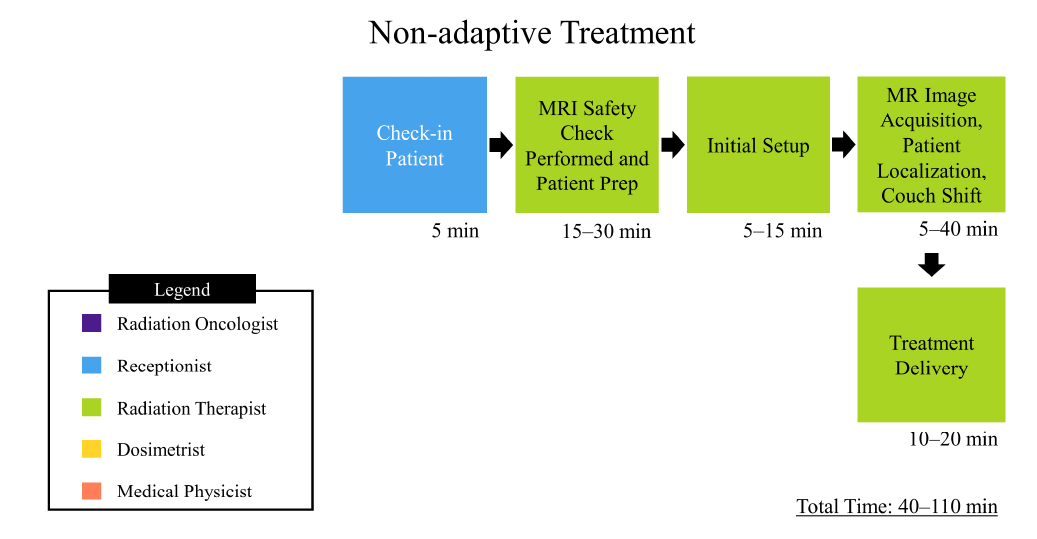
Figure 3. Depicts process map for MRgRT non-adaptive treatment. The times depicted are approxi- mated from data gathered by VCU health staff.